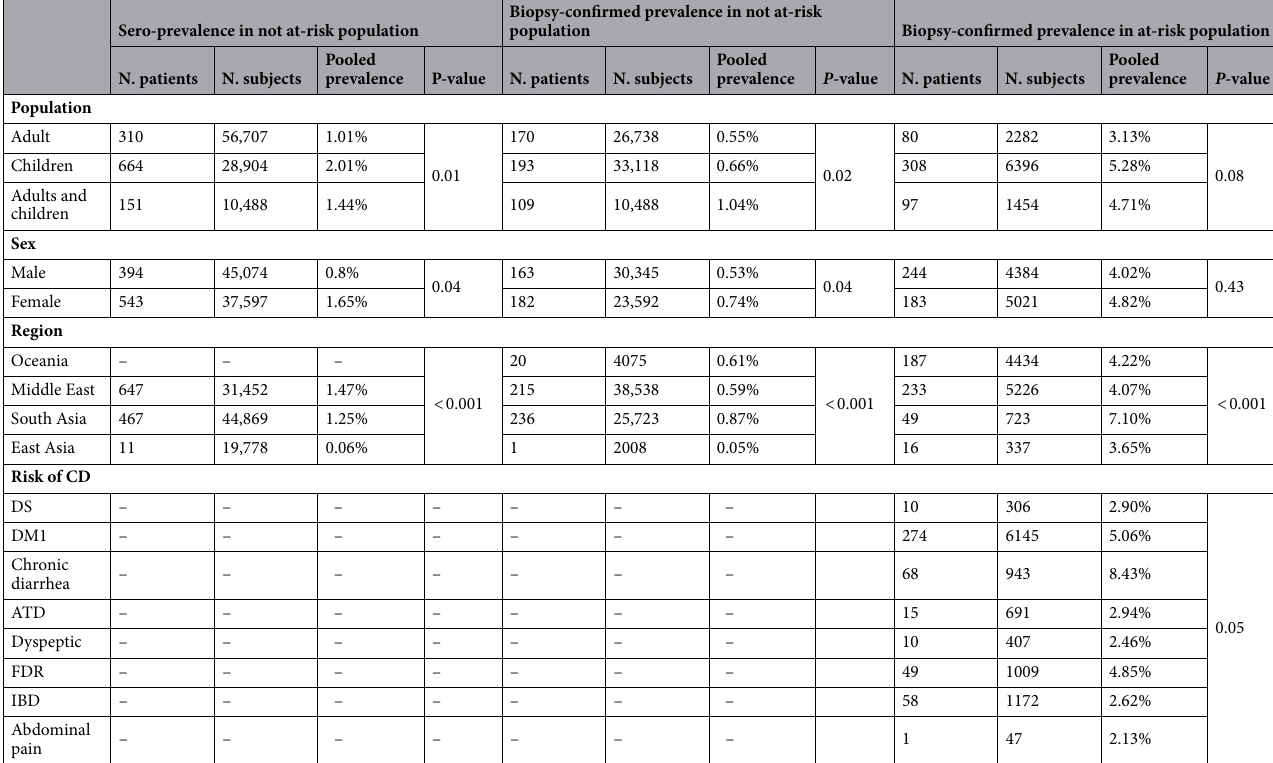
Table 4. Subgroup analysis for pooled prevalence of CD in Asian-Pacific region among at-risk and not at-risk populations. DM1 Diabetes Mellitus type1, DS Down syndrome, IBD Inflammatory bowel disease, ATD autoimmune thyroiditis diseases, FDR first-degree